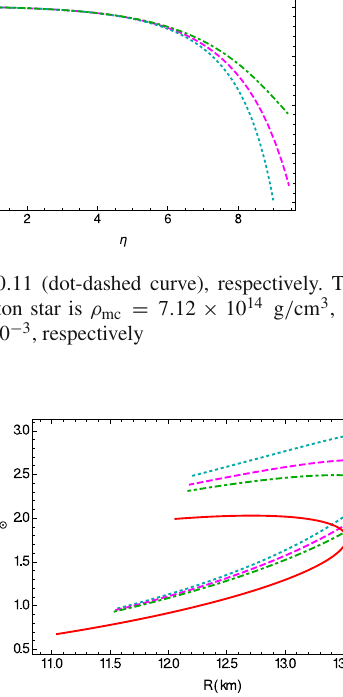
Fig. 11 Variation of the energy density ¯ ρ m (left panel) and of the inte- rior mass profile ¯ m (right panel) for three-form field photon stars in the presence of a Higgs-type potential as functions of η , for ¯ a = 0 . 007, and for three different values of the constant ¯ b : ¯ b = 0 (dashed curve),